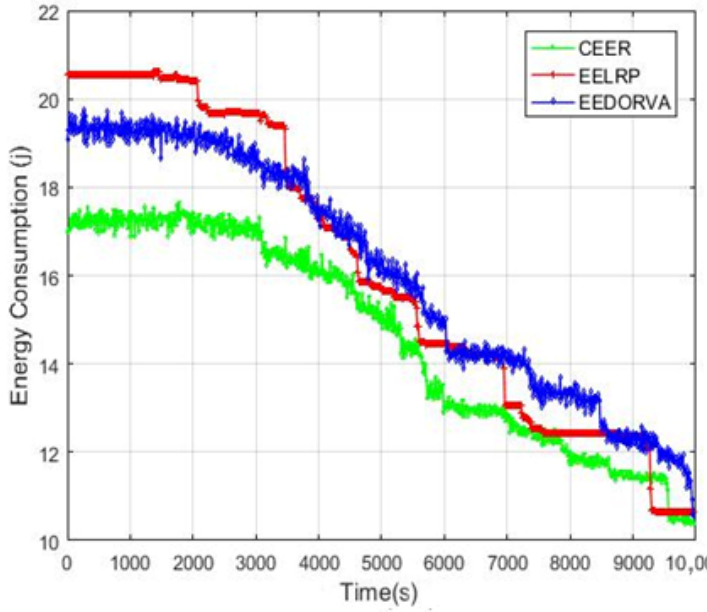
Figure 5. Energy consumption.